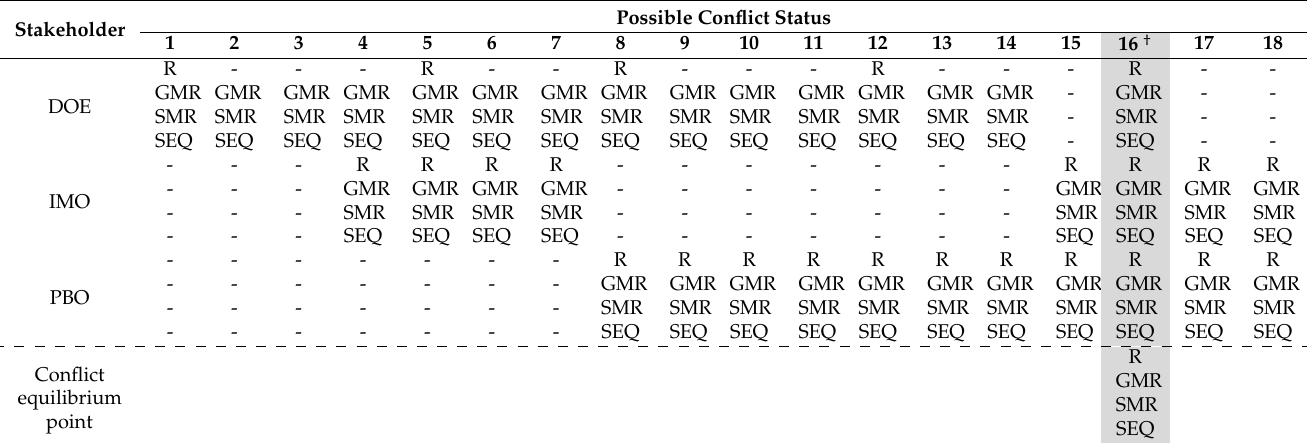
Table 8. Equilibrium analysis for industrial land development from conflicting stakeholders in Markazi province using the current scenario. † status 16 is highlighted to indicate the only one-sided movement for all possible